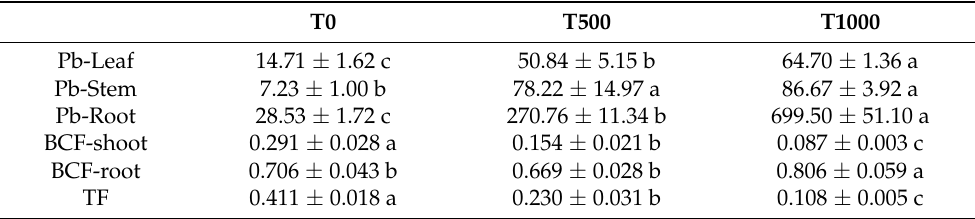
Table 3. The Pb concentration (mg kg − 1 ) and the bioconcentration factor (BCF) and translocation factor (TF) of Pb in R. chinensis under different treatments. Each value represents the mean of three replicates ± SD; Different letters indicate significant difference between the treatments ( p < 0.05).